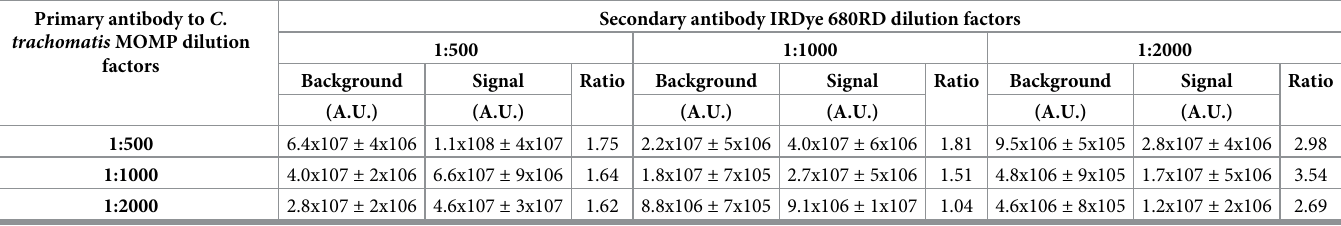
Table 1. Optimization of the concentrations for the primary and secondary antibodies. Primary antibody to C